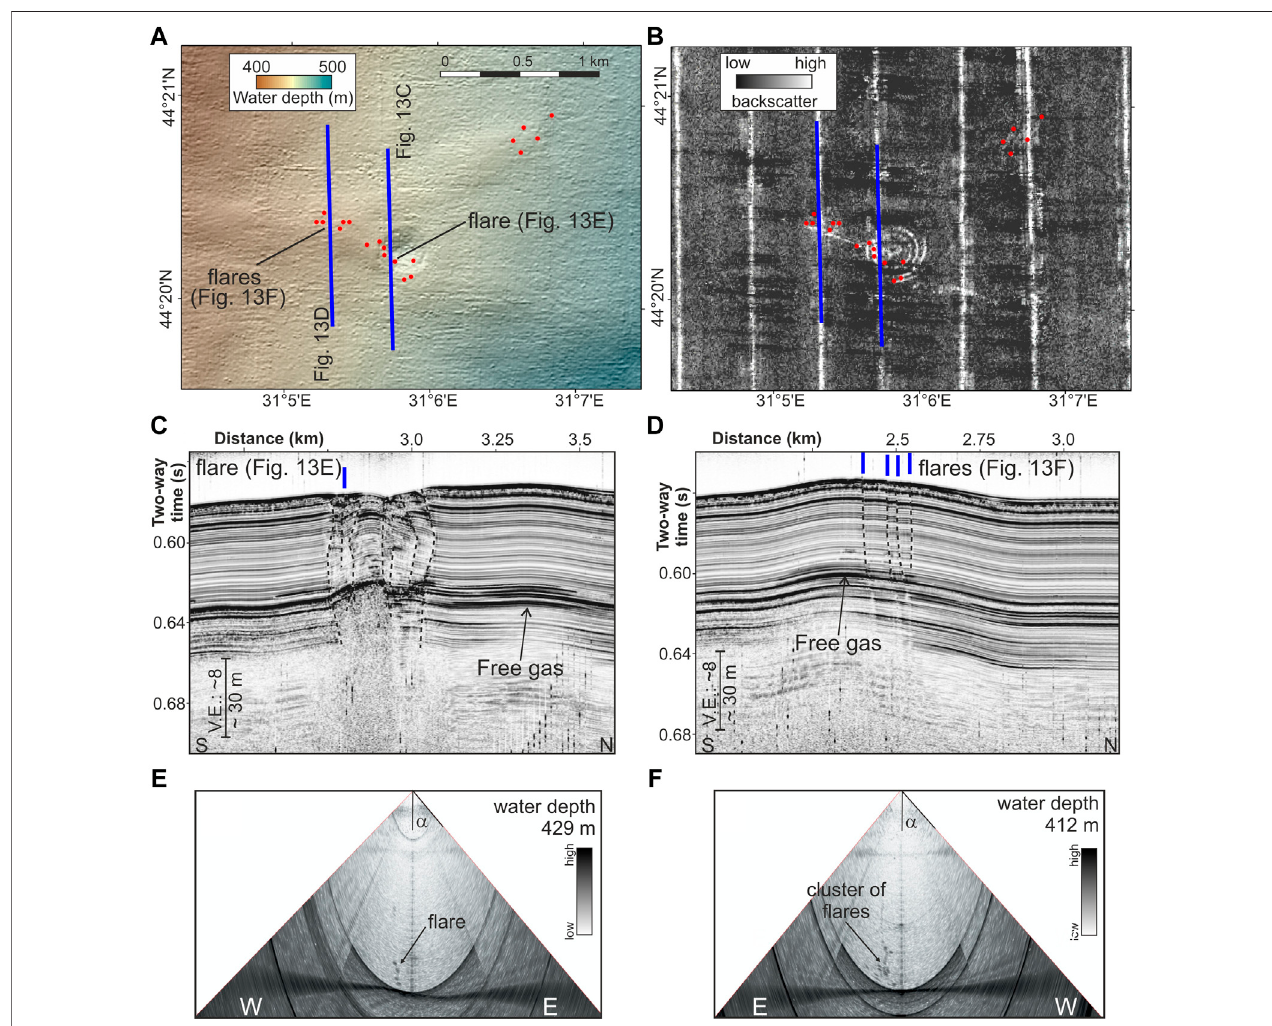
FIGURE 13 | Example of ring-faults around isolated pockmarks. (A) Multibeam bathymetry, (B) sea fl oor backscatter, with gas seepage shown as red dots. Blue lines indicate location of sub-bottom data shown in (C,D) . A nearly E-W trending fault cuts the pockmark and is identi fi ed by high backscatter signal along which gas escapeisseenNWofthepockmark,tightlylinkedtosmall-offsetfault-branches.Blackdashedlinesonsub-bottompro fi lerdatashowfaults. (E,F) Examplesofgas fl ares from the EM710 water column data (expedition MSM34). Beam-opening angle α is 60 ° .